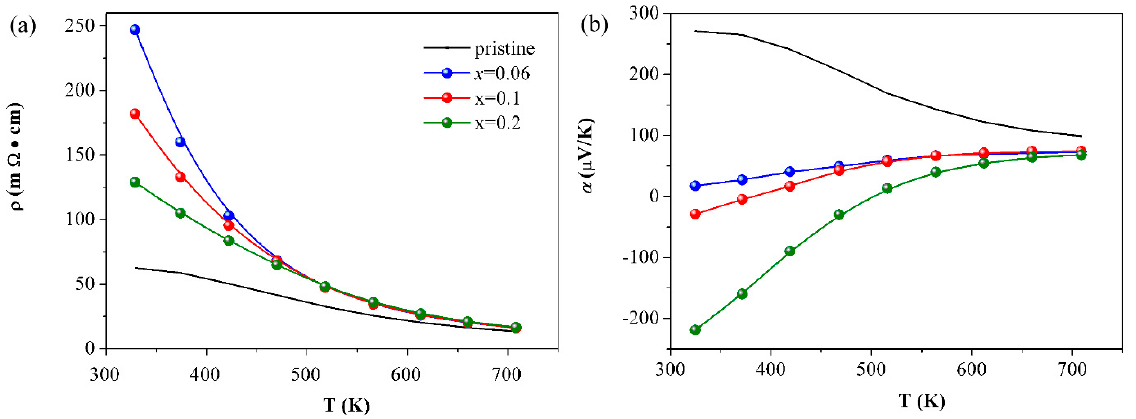
Figure 3. The resistivity ( a ) and Seebeck coefficients ( b ) as a function of the temperature for samples of Eu 5 In 2+ x Sb 6 ( x = 0, 0.06, 0.1, 0.2). Samples of Eu 5 − y La y In 2.2 Sb 6 ( y = 0.02, 0.04, 0.06, 0.08) were synthesized with the aim to intentionally